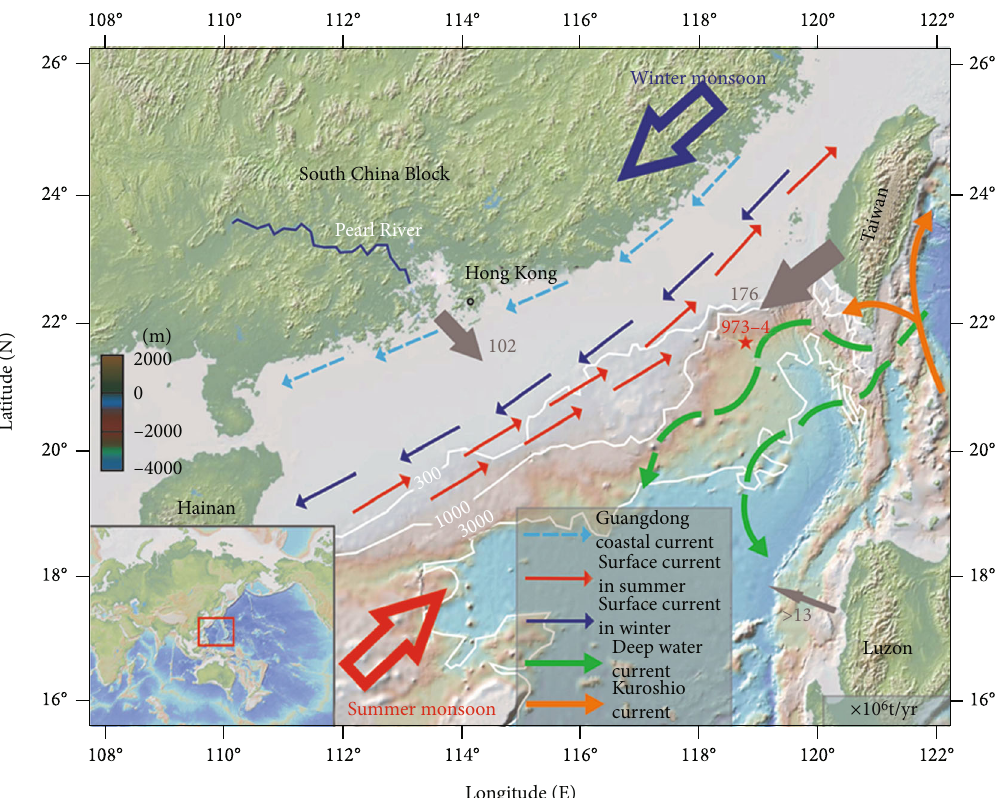
Figure 1: Overview map of the northern part of the SCS, including core location 973-4, monsoon and current systems, fl uvial drainage systems, and their annual suspended sediment discharge to the South China Sea. Core 973-4 is labeled by red star. Monsoon and current systems are labeled by colored arrows. Monsoon winds after Webster [11], Guangdong coastal currents after Fang et al. [8], Kuroshio Current after Caruso et al. [7], deep water currents after Zhao et al. [12]. Fluvial drainage systems and their annual discharge to SCS are represented by grey arrows with numbers (in million metric tons, Mt/yr), and the size represents the fl ux (summarized by [3]). The base map was generated from